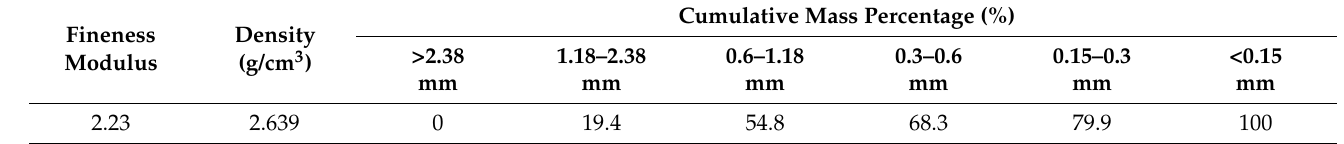
Table 3. Physical properties of ISO standard sand.